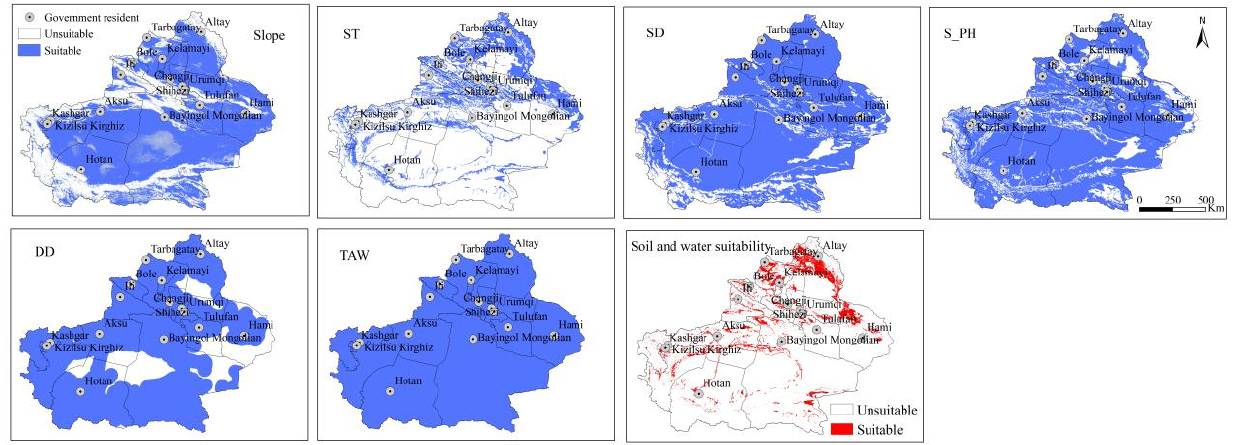
Figure 7. Suitable water and soil area for cotton seed production, ST, soil texture; SD, soil depth; S_PH, soil PH; DD, drainage density; TAW, the average annual total amount of water resources per unit area.